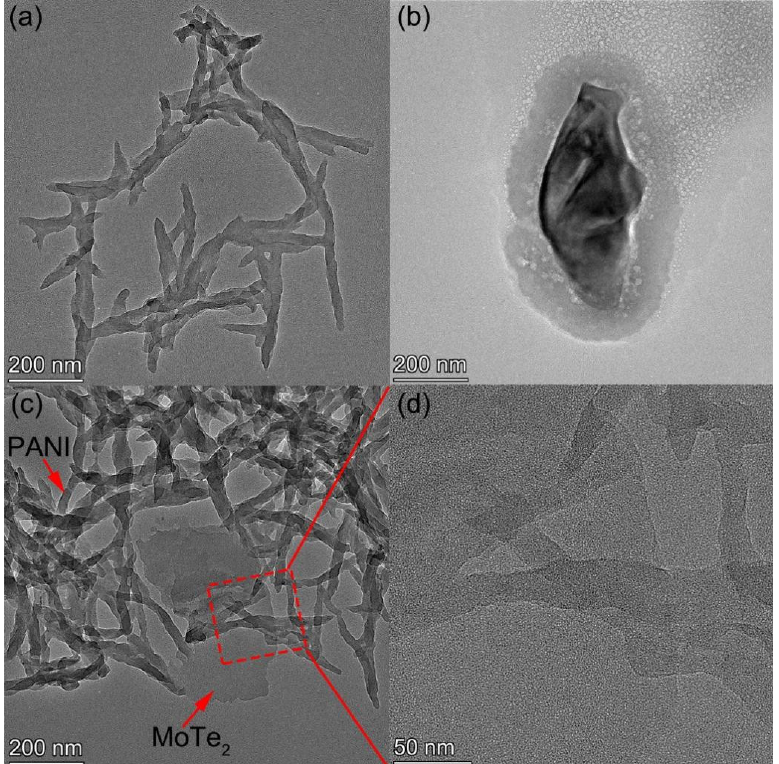
Figure 3. High-resolution TEM (HRTEM) images of ( a ) pure PANI, ( b ) MoTe 2 nanosheets, ( c ) MoTe 2 /PANI nanocomposites (200 nm scale); ( d ) HRTEM image of MoTe 2 /PANI nanocomposites (50 nm scale).